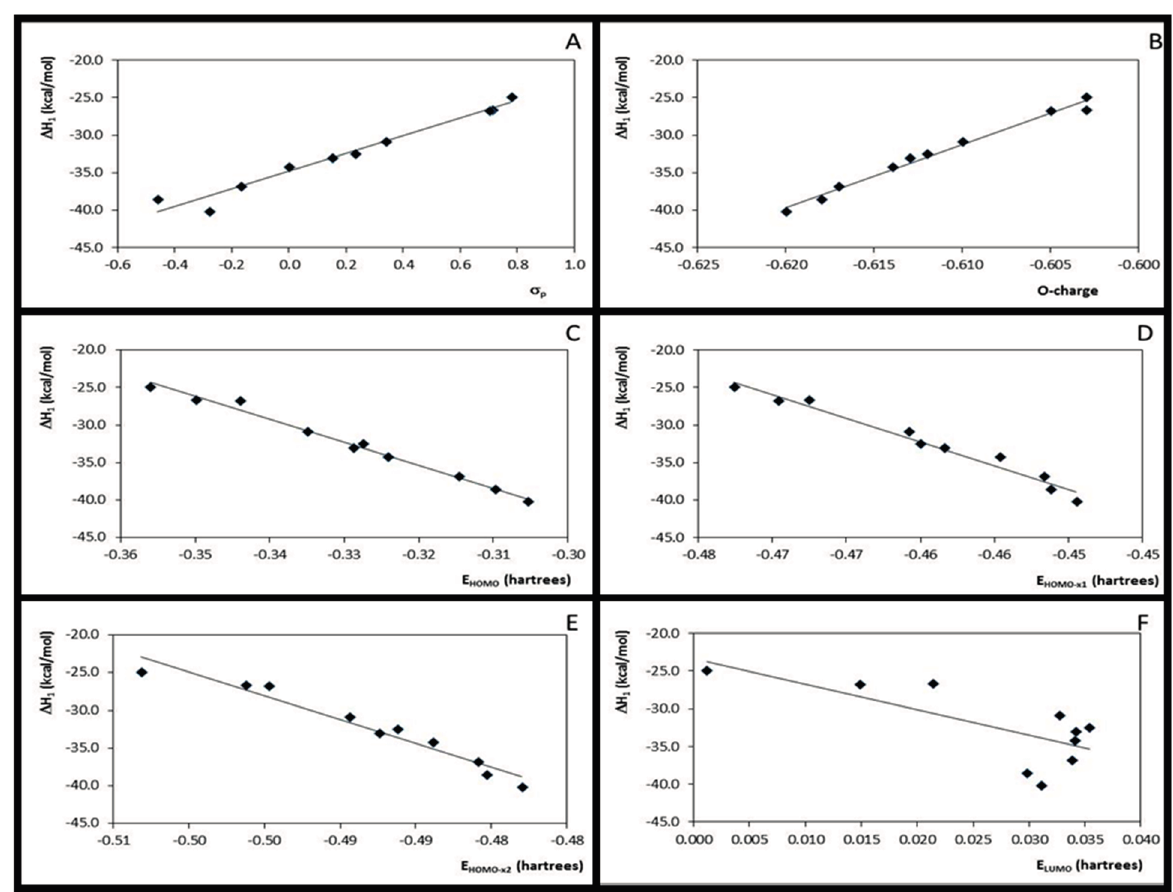
Figure 3. Plots for the correlation between enthalpies ( Δ H 1 ) values and Hammett substituent constants ( A ); O -charges ( B ) and HOMO, HOMO-x 1 , HOMO-x 2 and LUMO energies ( C – F ,